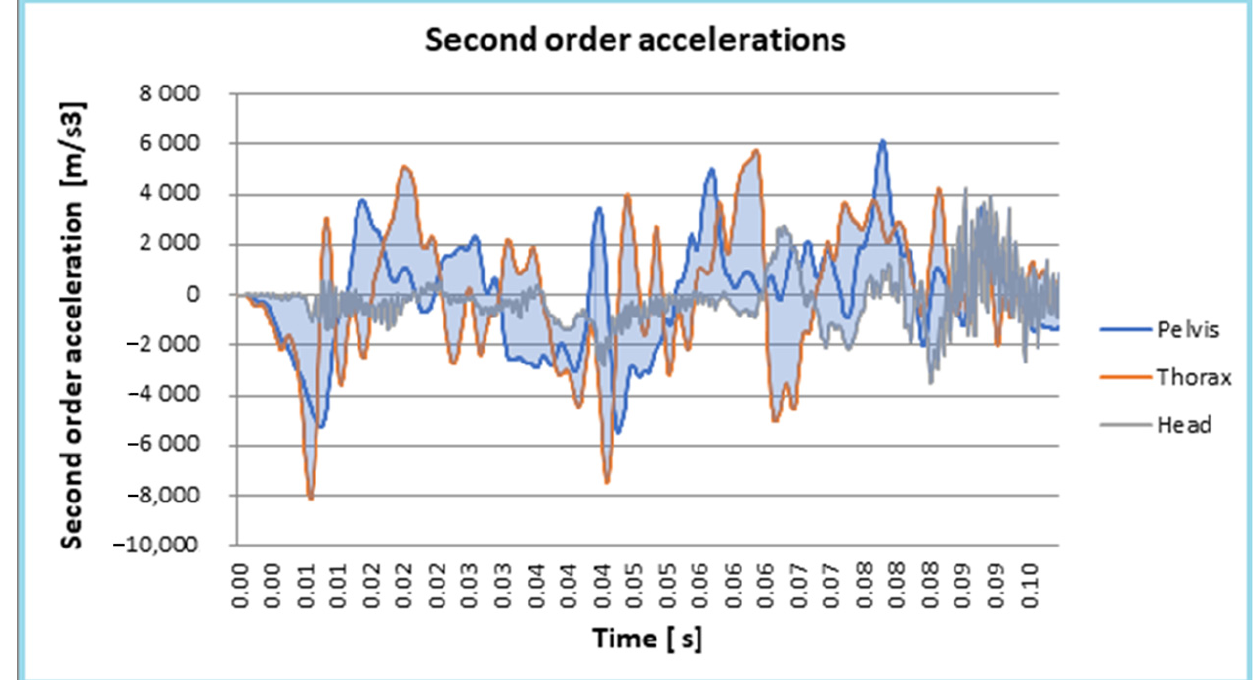
Figure 23. Second-order accelerations.